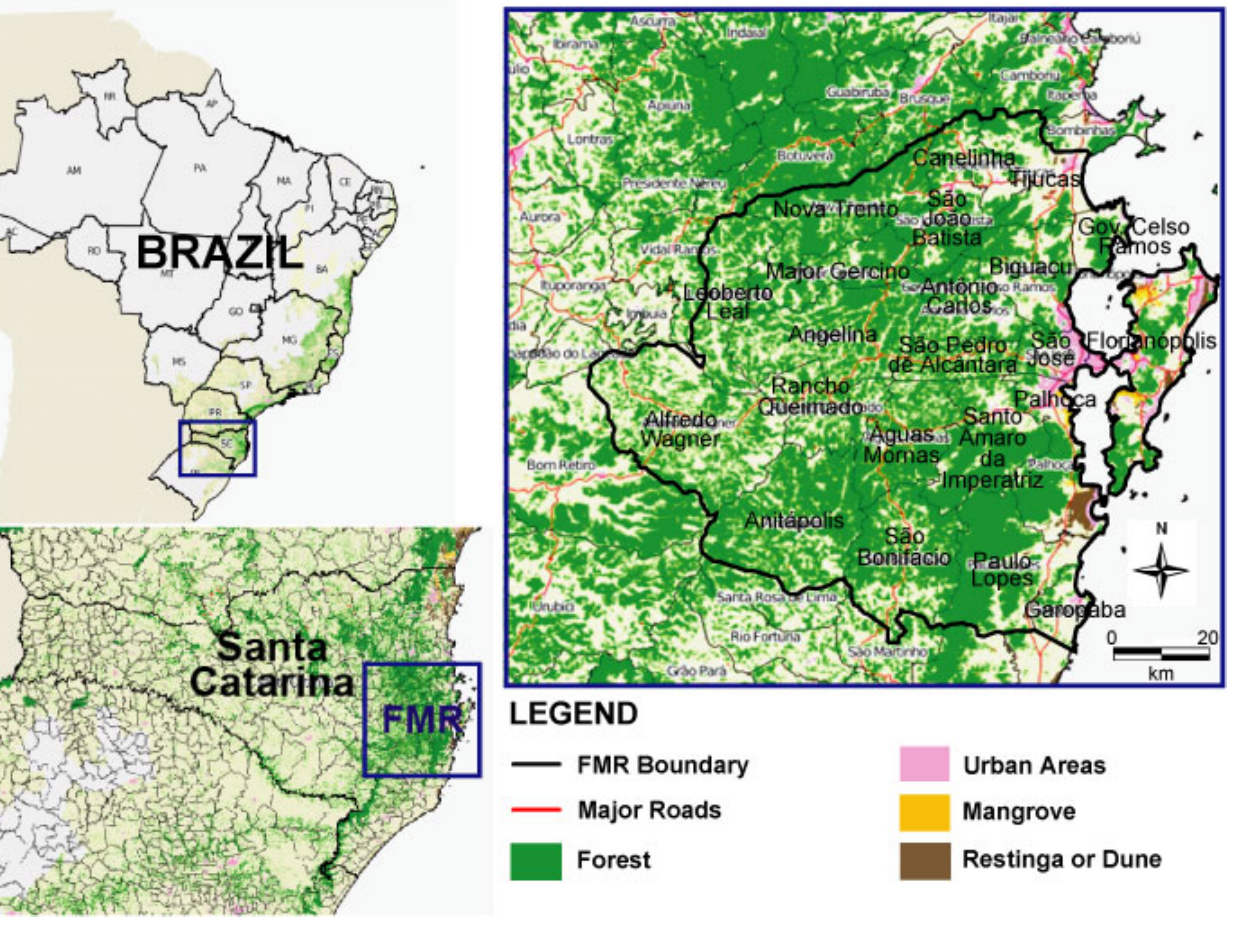
Fig. 1. Atlantic Forest remnants in Brazil, Santa Catarina, and the Florianópolis metropolitan region (FMR) in 2005. Adapted and translated from maps available online from the Fundação SOS Mata Atlântica